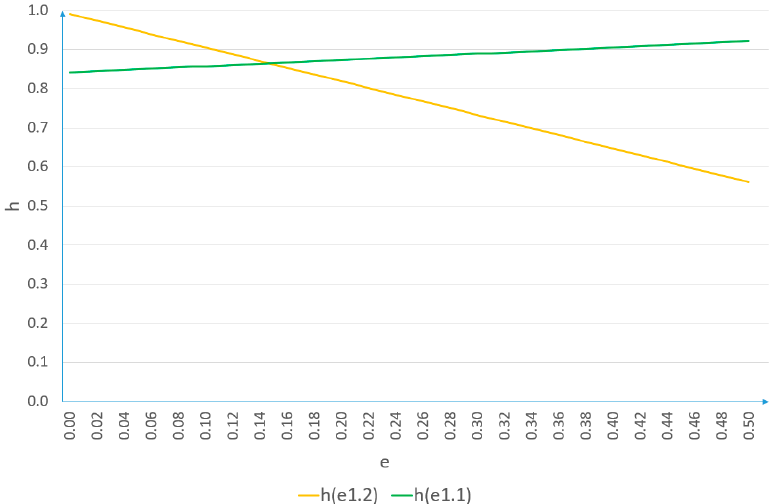
Figure 8. The result of final hypothesis simulation in observation function (operation result of the software written by one of the authors of the article).